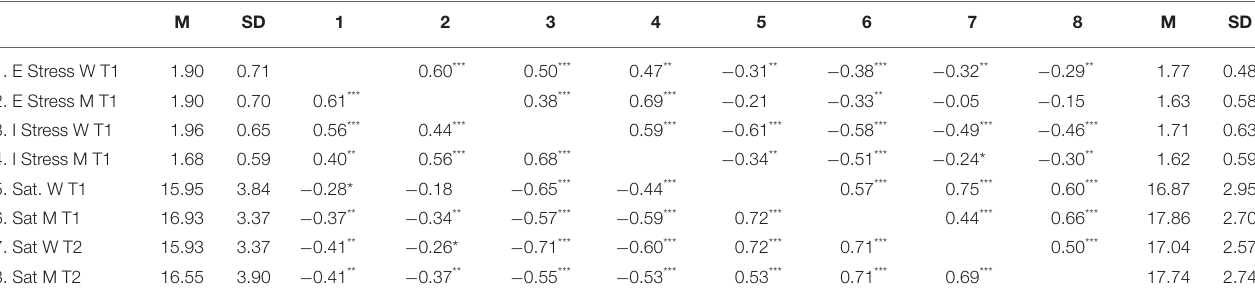
TABLE 1 | Means, Standard deviations and correlations among the variables for low SES participants ( N = 63, below the diagonal) and high SES participants ( N = 81; above the diagonal). M SD